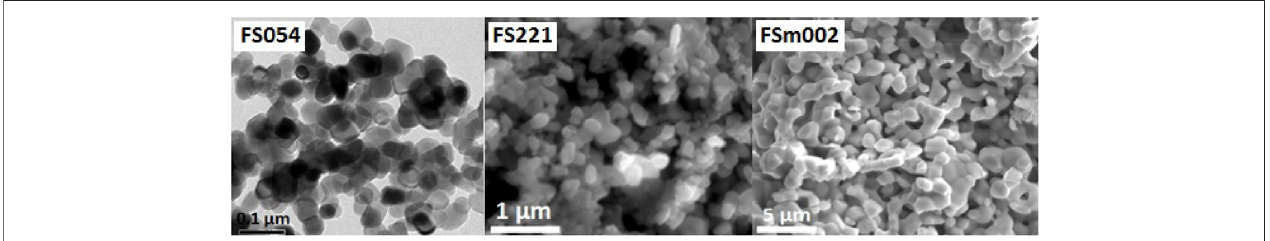
FIGURE 2 | TEM and SEM images of initial α -Fe 2 O 3 with different particle sizes.